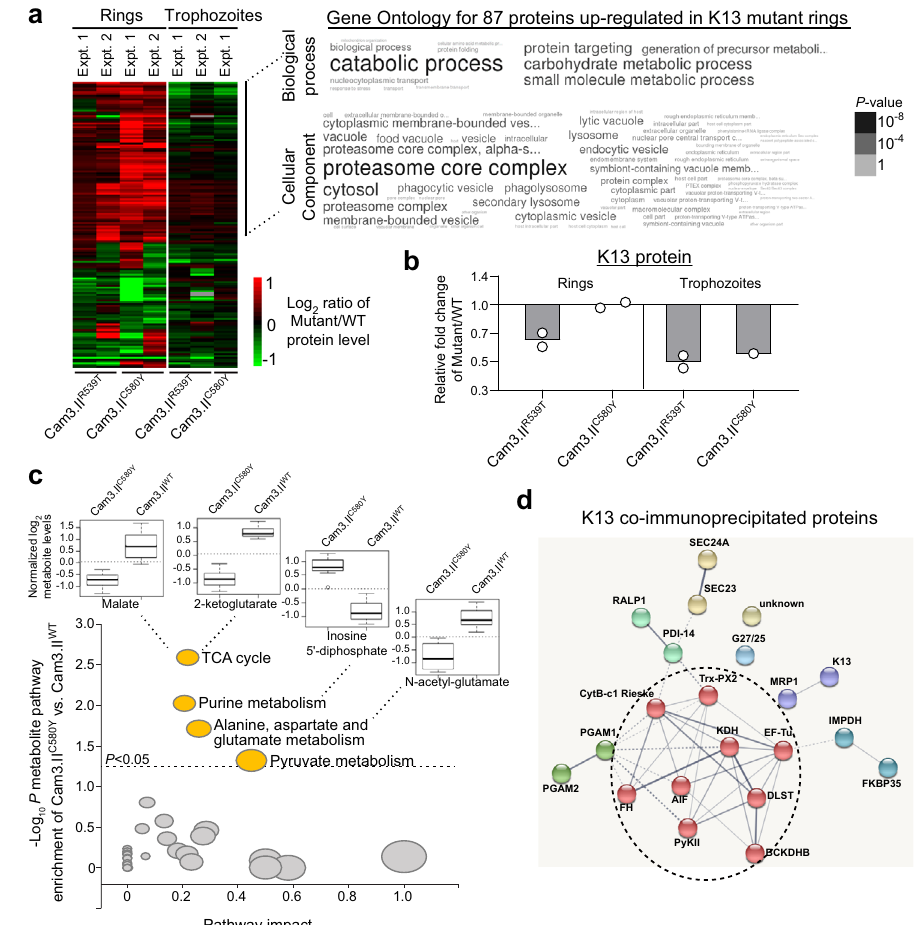
Fig. 3 K13 mutations associate with differential expression of proteins involved in proteasome-mediated turnover and protein folding, and altered levels of TCA cycle, purine, glutamate, and pyruvate metabolites at the ring stage. a Heat map of the log 2 fold change of signi fi cantly different protein levels in Cam3.II R539T or Cam3.II C580Y mutants relative to the isogenic Cam3.II WT parasites for 155 DE proteins identi fi ed from isobaric labeling-based quantitative proteomics. Within each biological replicate, two- sided t -tests were performed for peptide levels belonging to each protein between K13 mutant and WT isogenic lines. Word cloud representation of functional analysis of signi fi cant biological processes and cellular components (Gene Ontology database) for the 87 up-regulated proteins in K13 mutant rings, along with their corresponding P values. b Relative fold change of K13 protein levels in Cam3.II R539T and Cam3.II C580Y mutants vs. Cam3.II WT , at the ring and trophozoite stages. K13 protein was ~2-fold lower in the Cam3.II R539T rings and trophozoites, as compared to the isogenic Cam3.II WT line. Data points are shown with means of the averaged normalized peptide abundance across two independent experiments for each strain and stage, except for C580Y trophozoites. c Scatterplot of the enrichment – log 10 P score (using a two-sided t - test adjusted for multiple comparisons using the Holm – Bonferroni method) of the metabolite pathway and % pathway impact calculated from metabolite set enrichment analysis comparing Cam3.II C580Y and Cam3.II WT rings at basal level. Differential expression of four pathways ( P < 0.05; gold color) is shown. Circle sizes re fl ect the pathway impact value, which represents the cumulative percentage of matched metabolite nodes (i.e. the importance measure) with respect to the total pathway based on pathway topological analyses. Box plots show reduced normalized log 2 levels of the two TCA cycle metabolites, malate, and 2-ketoglutarate, and the glutamate metabolite, N -acetyl glutamate, but increased level of the purine metabolite, inosine 5 ′ - diphosphate in Cam3.II C580Y as compared to Cam3.II WT rings. Data are represented as box and whisker plots with medians, interquartile ranges, and 95% con fi dence intervals ( N = 3 independent experiments). d Interactome network of the 21 putative K13-interacting partners detected by co- immunoprecipitation (co-IP) with the K13-speci fi c monoclonal antibodies E3 and D9 (ref. 41 ) and mass spectrometry experiments using K13 WT, C580Y, or R539T samples from either the Cam3.II or CamWT strain background 16 . Proteins were clustered using the Markov Cluster Algorithm in STRING. Line thickness depicts the con fi dence/strength of the relationship between proteins (nodes). Solid lines represent intra-cluster interactions while dashed lines represent the interaction between clusters. Red nodes correspond to mitochondrial proteins, which are over-represented in this list of co-IP proteins. Gene abbreviations are listed in Supplementary Data 5.